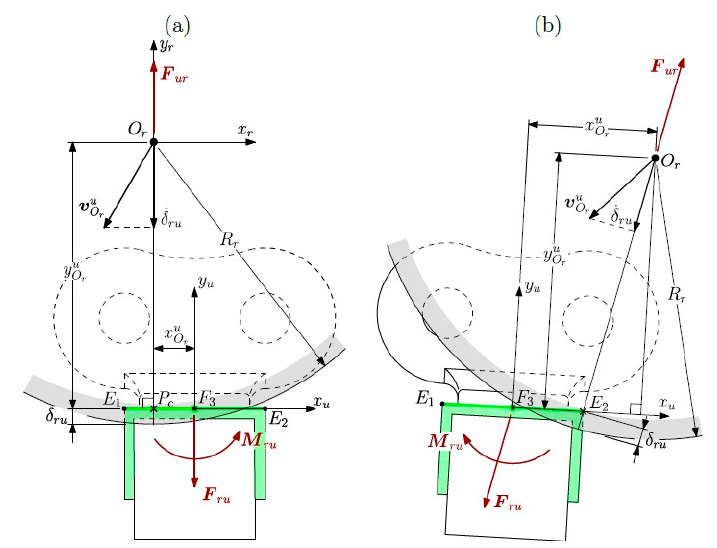
Figure 16. Illustration of the contact between a sprocket tooth and a roller pin. ( a ) the projection of the roller center onto the line of contact falls between the edges E 1 and E 2 . ( b ) the projection of the roller center onto the line of contact falls “beyond” the second edge E 2 .